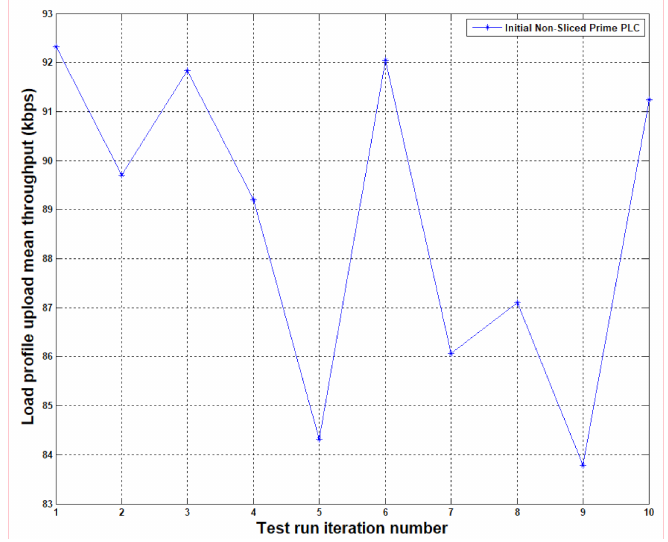
Figure 7. Thresholds observed on unreliable PLC communication channel with no data slicing at application level.